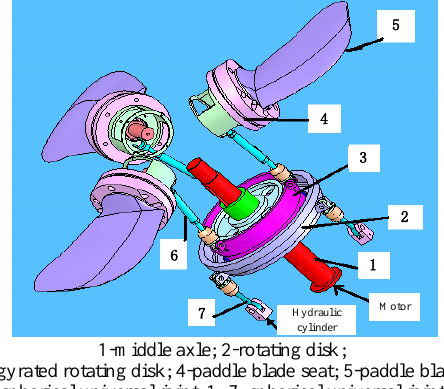
Figure 2. Motion relationships of the main equipment in the CPP system.